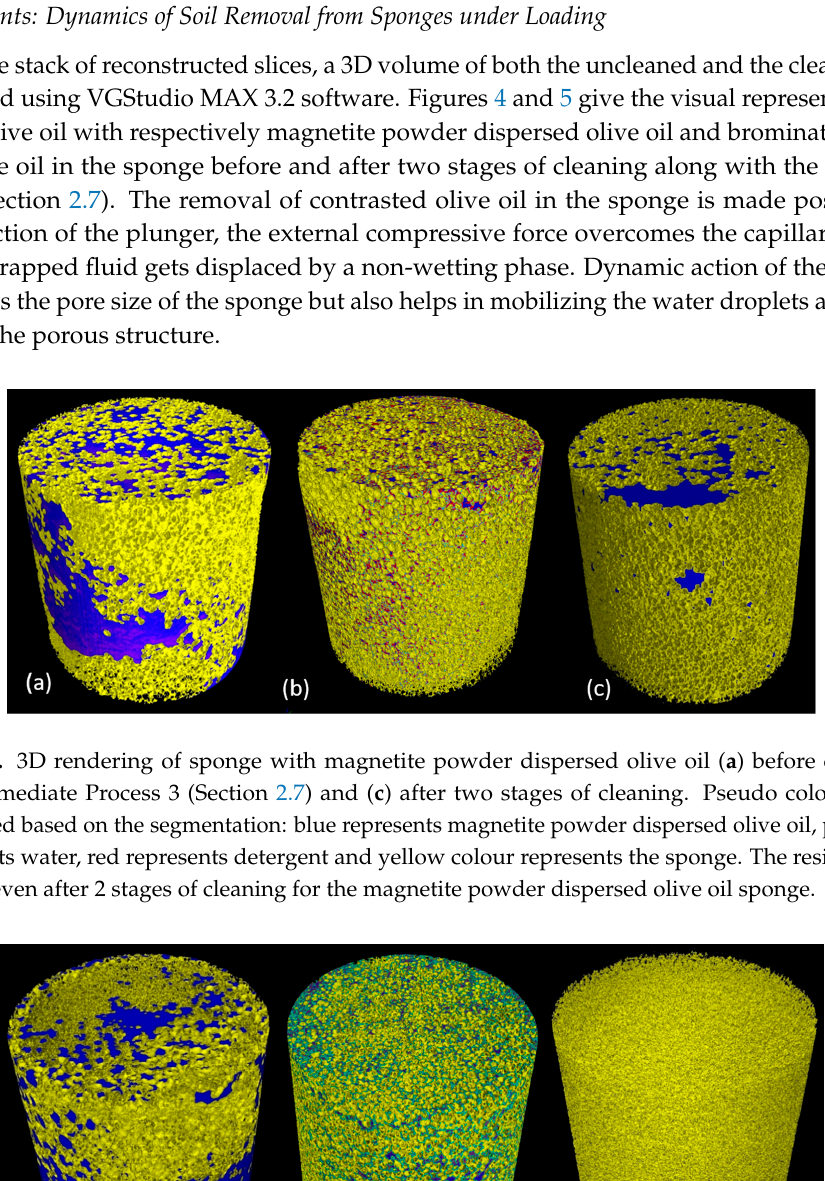
Table 3. Percentage of cleaning for two sponges, sponge 1 (magnetite powder dispersed olive oil) and sponge 2 (brominated vegetable oil mixed olive oil).